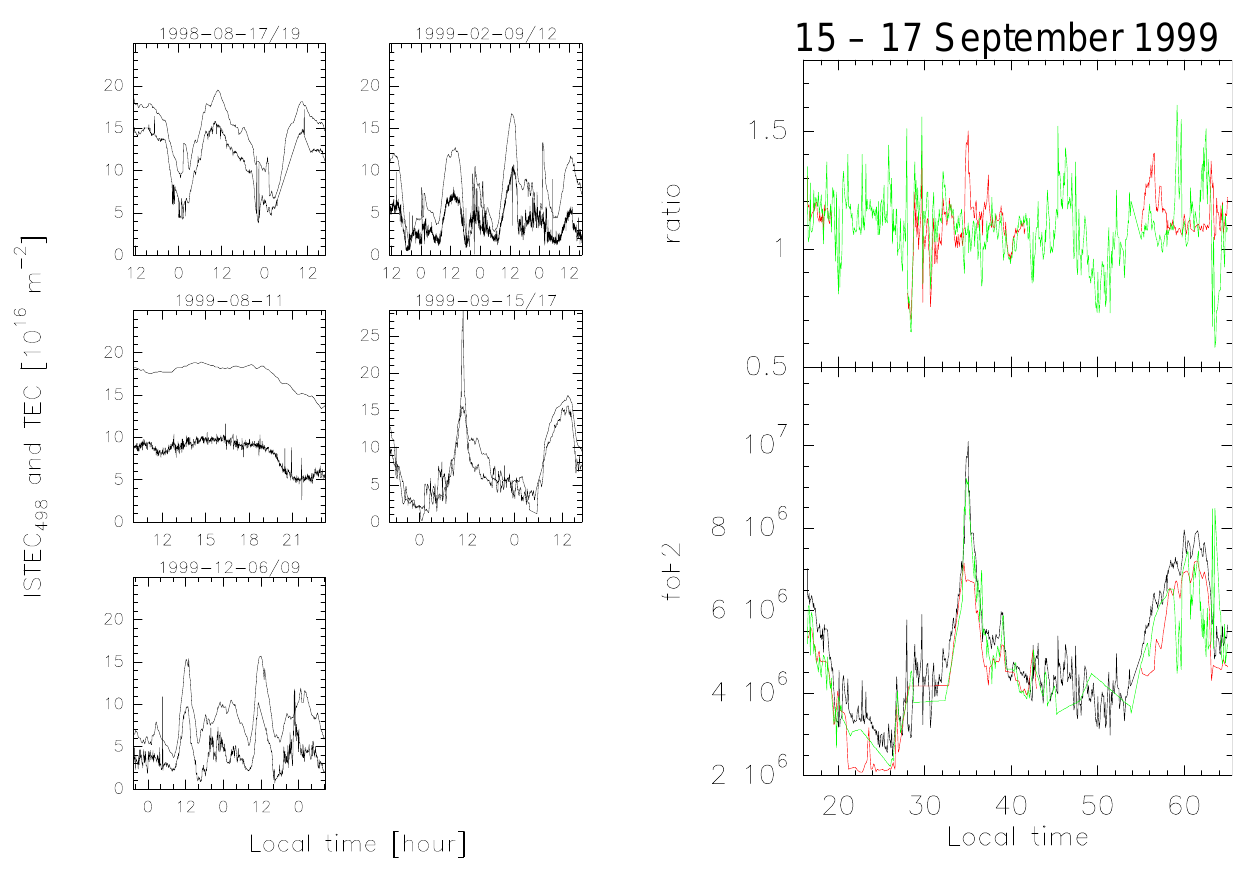
Fig. 2. fo F2 comparison between the IS radar data (black), the Dy- nasonde (red) and the DGS (green). The top panel shows the ratio between the ionosonde- fo F2 data and the IS- fo F2 data in the same colour